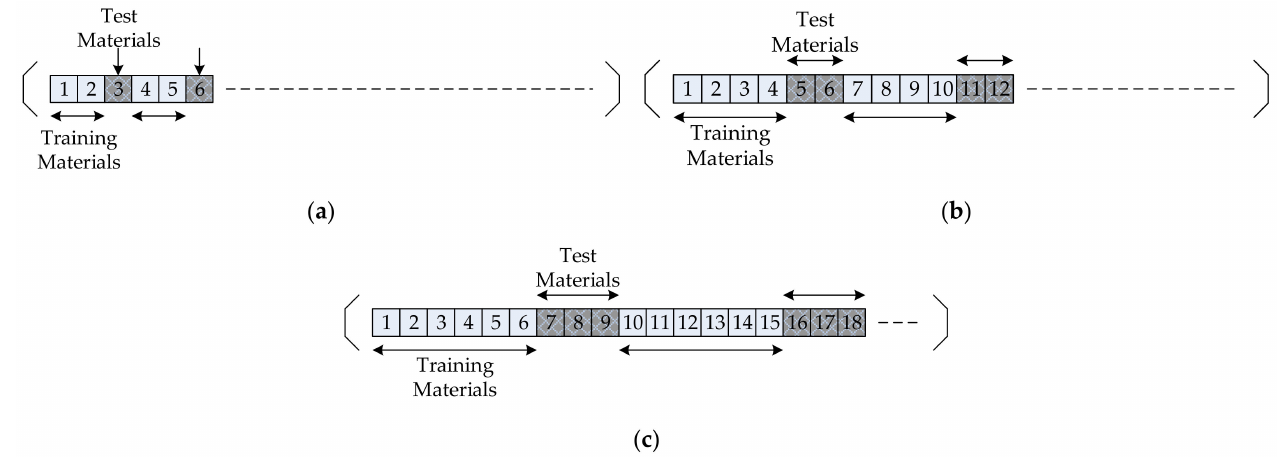
Figure 15. Schematic diagram of training data and test data architecture: ( a ) Architecture I: 2/3 are training materials, and 1/3 are test materials; ( b ) Architecture II: 4/6 for training and 2/6 for testing; ( c ) Architecture III: 6/9 for training data and 3/9 for testing data.